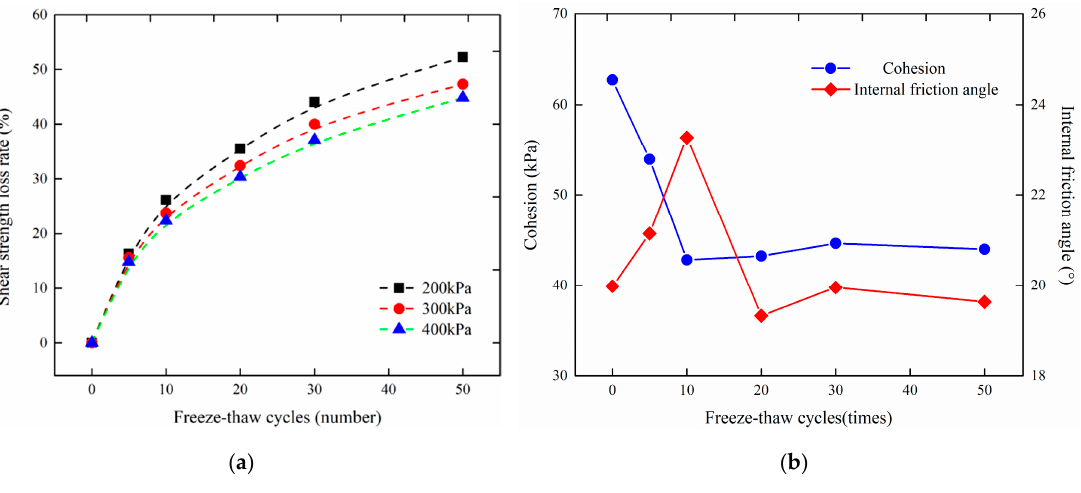
Figure 7. Strength degradation. ( a ) Shear strength loss rate under freeze–thaw cycles. ( b ) Mechanical parameters.